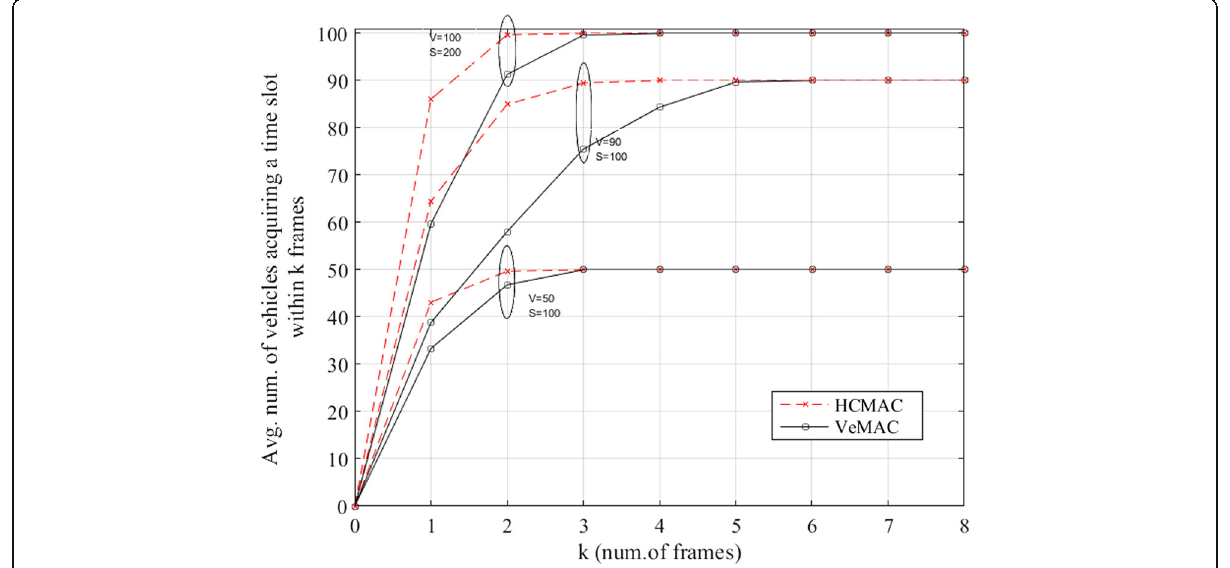
Fig. 17 Avg. number of vehicles acquiring a time slot within k frames (simulation results, W =